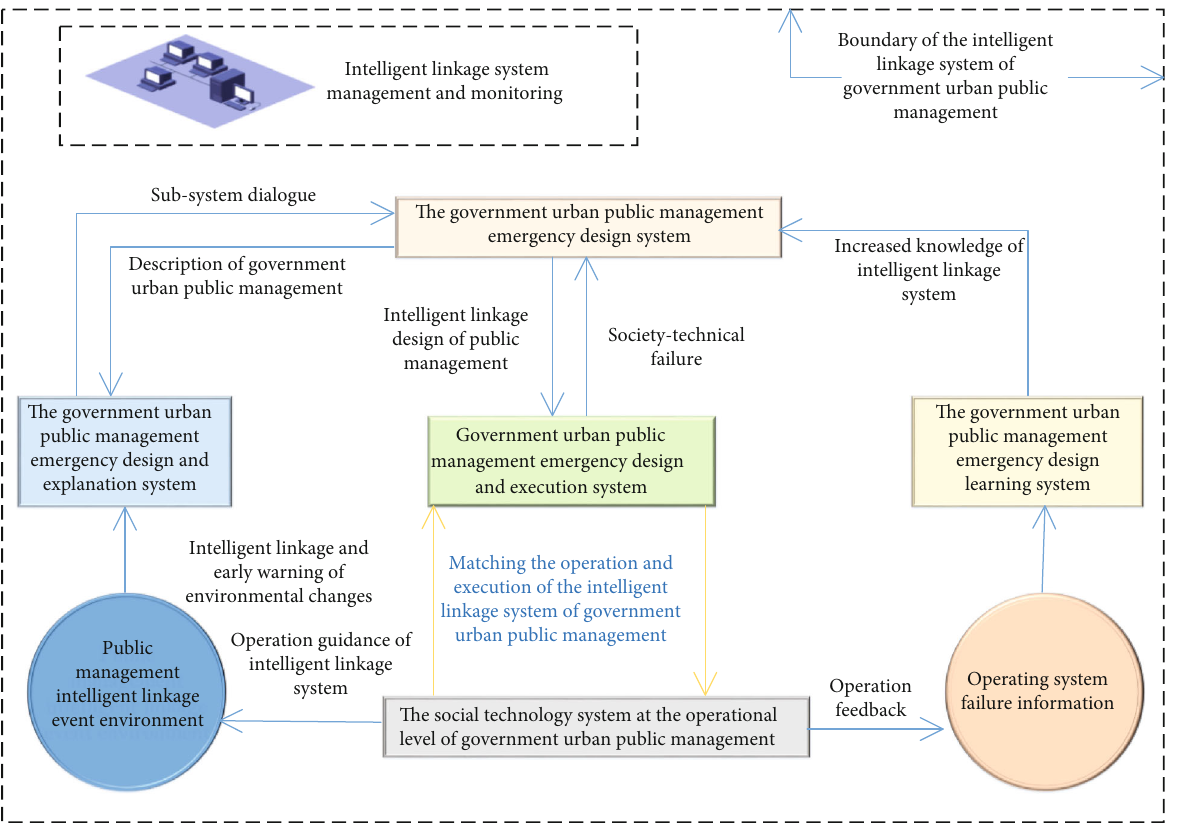
Figure 1: Intelligent joint governance of social-technical emergencies under the government urban public management.